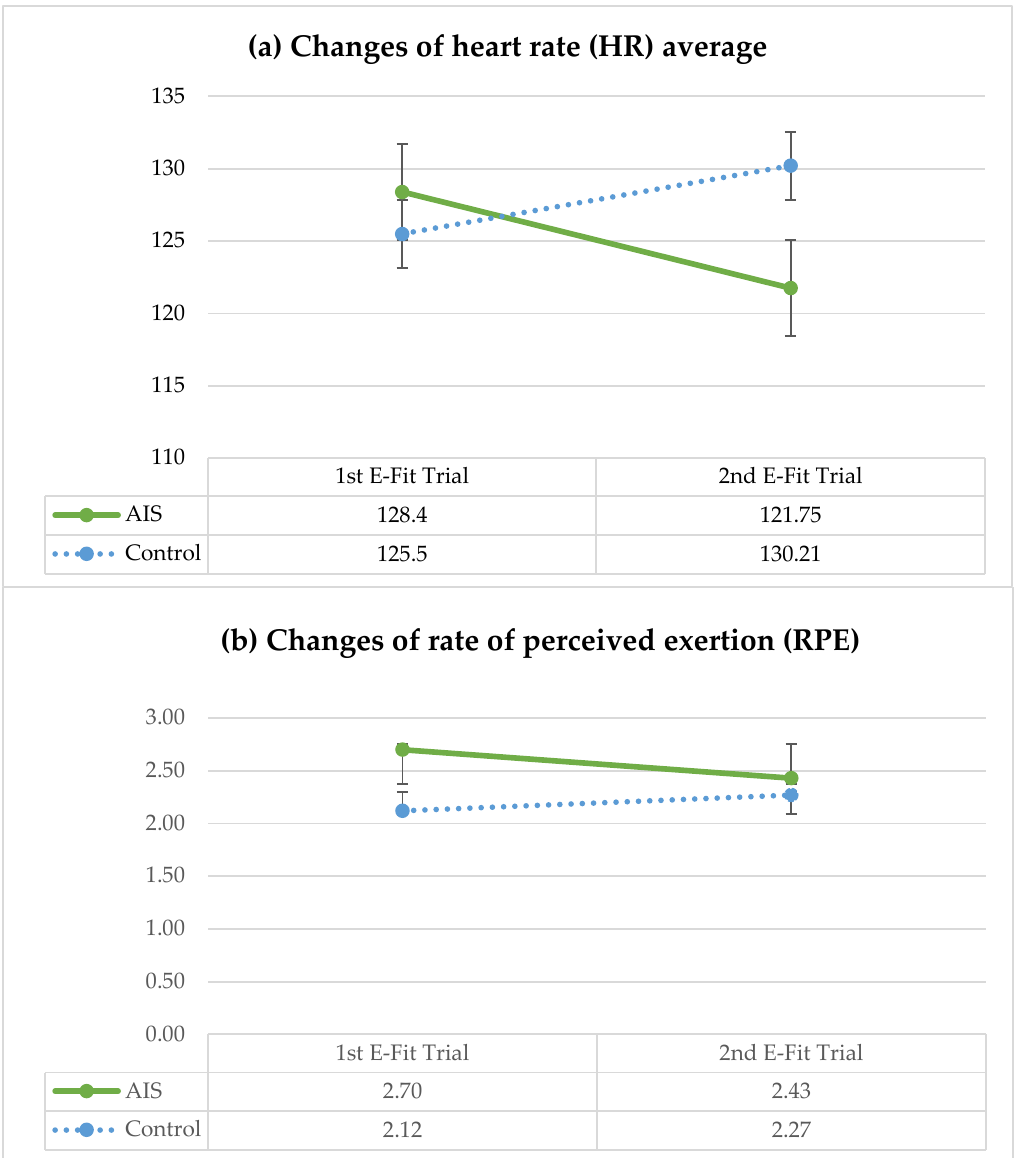
Figure 1. Changes of: ( a ) heart rate (HR) average; and ( b ) rate of perceived exertion (RPE), between AIS and control groups in both E-Fit trials.